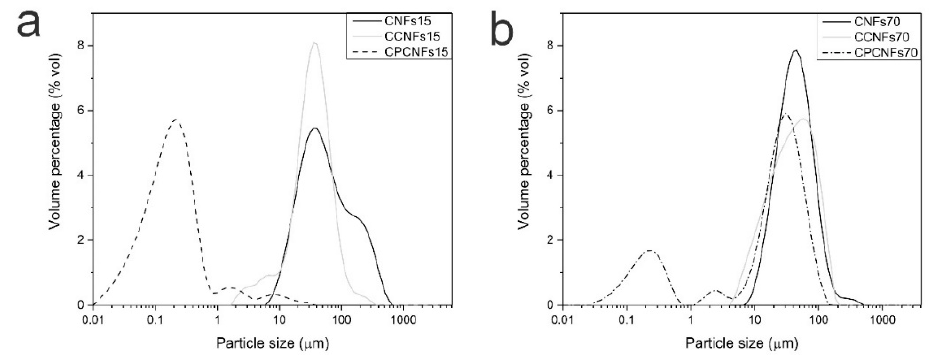
Figure 6. Particle size distribution of suspensions containing 0.15 wt.% ( a ) and 0.7 wt.% ( b ) of CNFs, with and without oil and surfactant.